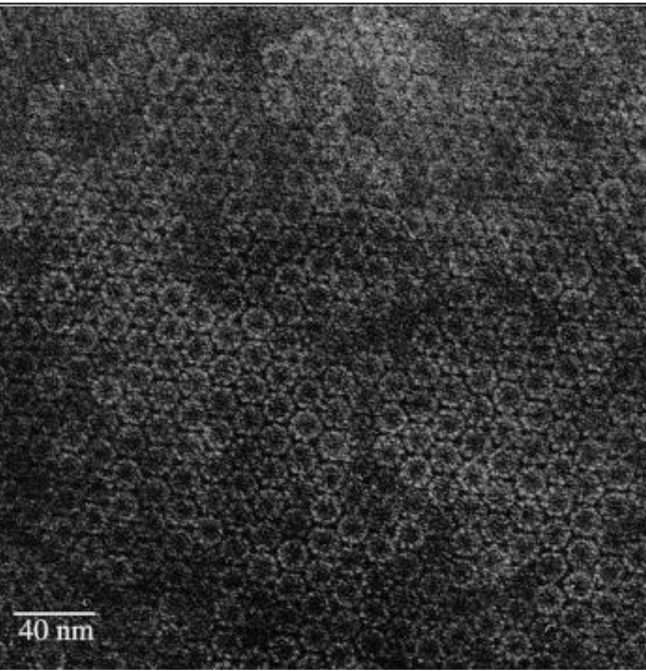
Figure 43. A negatively stained crystalline area of TF55 β -subunits reconstituted into oligomers. Reprinted with permission from Elsevier, 1998